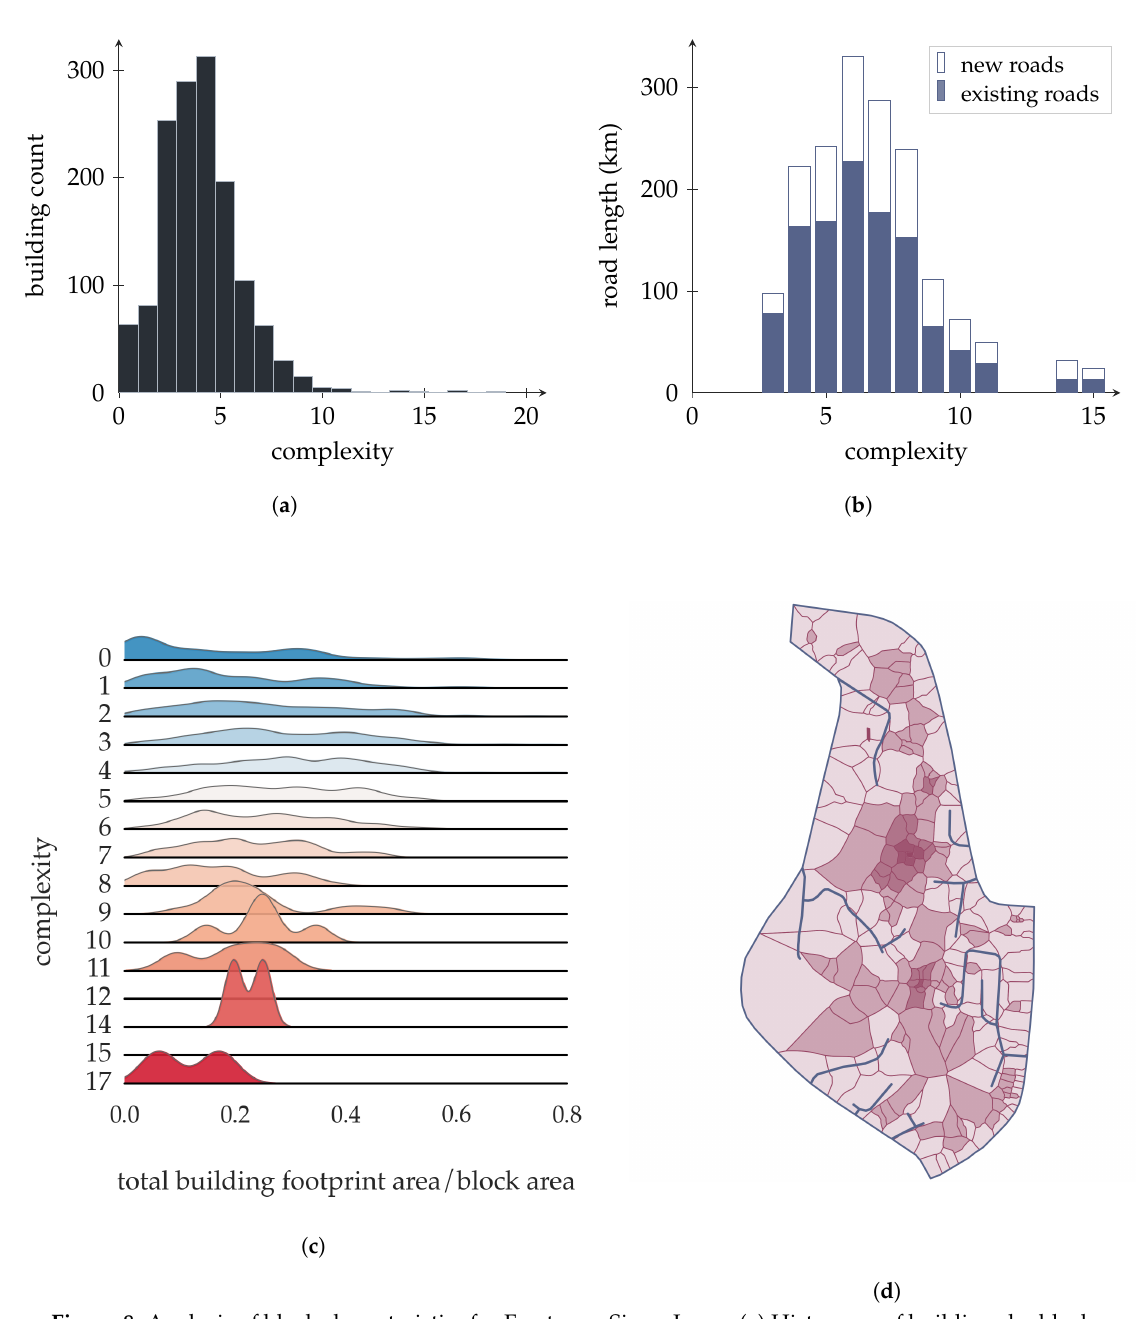
Figure 8. Analysis of block characteristics for Freetown, Sierra Leone ( a ) Histogram of buildings by block complexity. ( b ) Distribution of proposed new road construction by block complexity. ( c ) Kernel density estimates for distributions of building-block areal ratios at each value of k observed (denoted “complexity” in the figure). ( d ) Map of Freetown administrative campus containing Parliament and other civic buildings in which limited street access occurs by